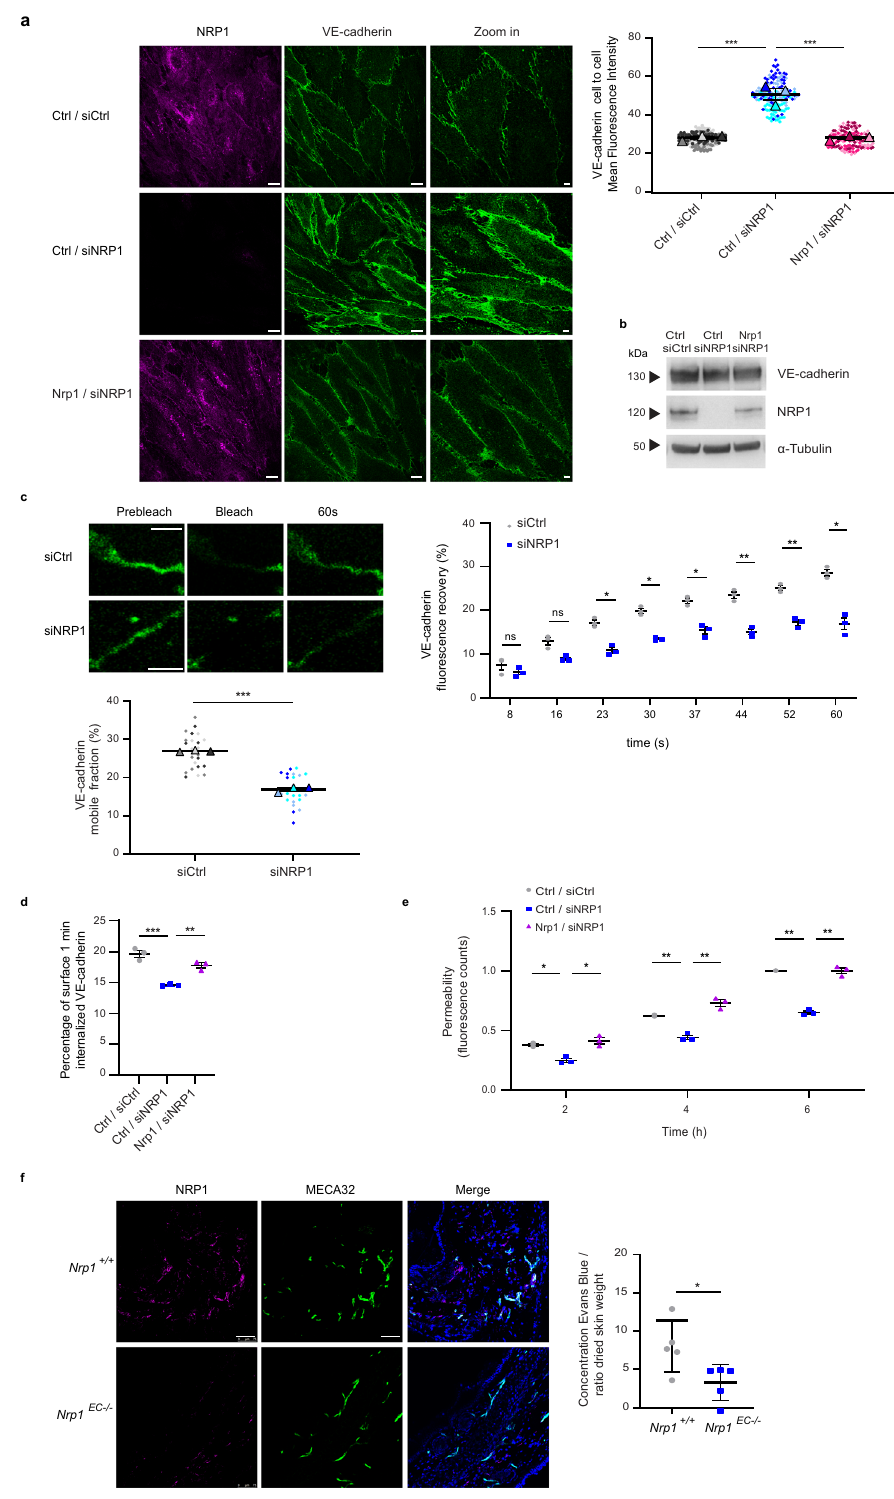
Con fl uent ECs were surface labeled with cleavable biotin at 4 °C and then incubated at 37 °C for 1 min to allow internalization of biotinylated plasma membrane proteins. Next, the biotin remaining on cell-surface proteins was cleaved and VE-cadherin endocytosis quanti fi ed by capture ELISA on cell lysates, employing an anti-VE- cadherin Ab as a catcher. Knockdown of NRP1 diminished by 26 ± 0.004% the quantity of VE-cadherin internalized by ECs and